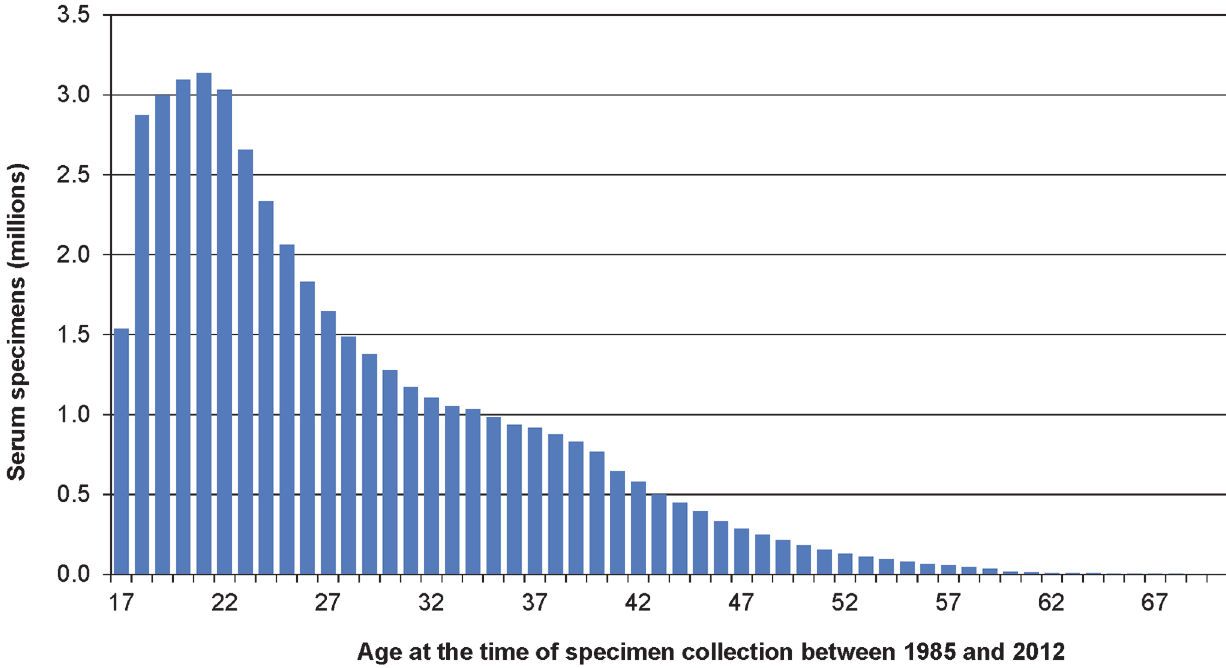
Fig 1. Distribution of ages a at the time of collection for specimens in the DoD Serum Repository. a. Approximately 30,000 outliers younger than 17 years and older than 70 years were